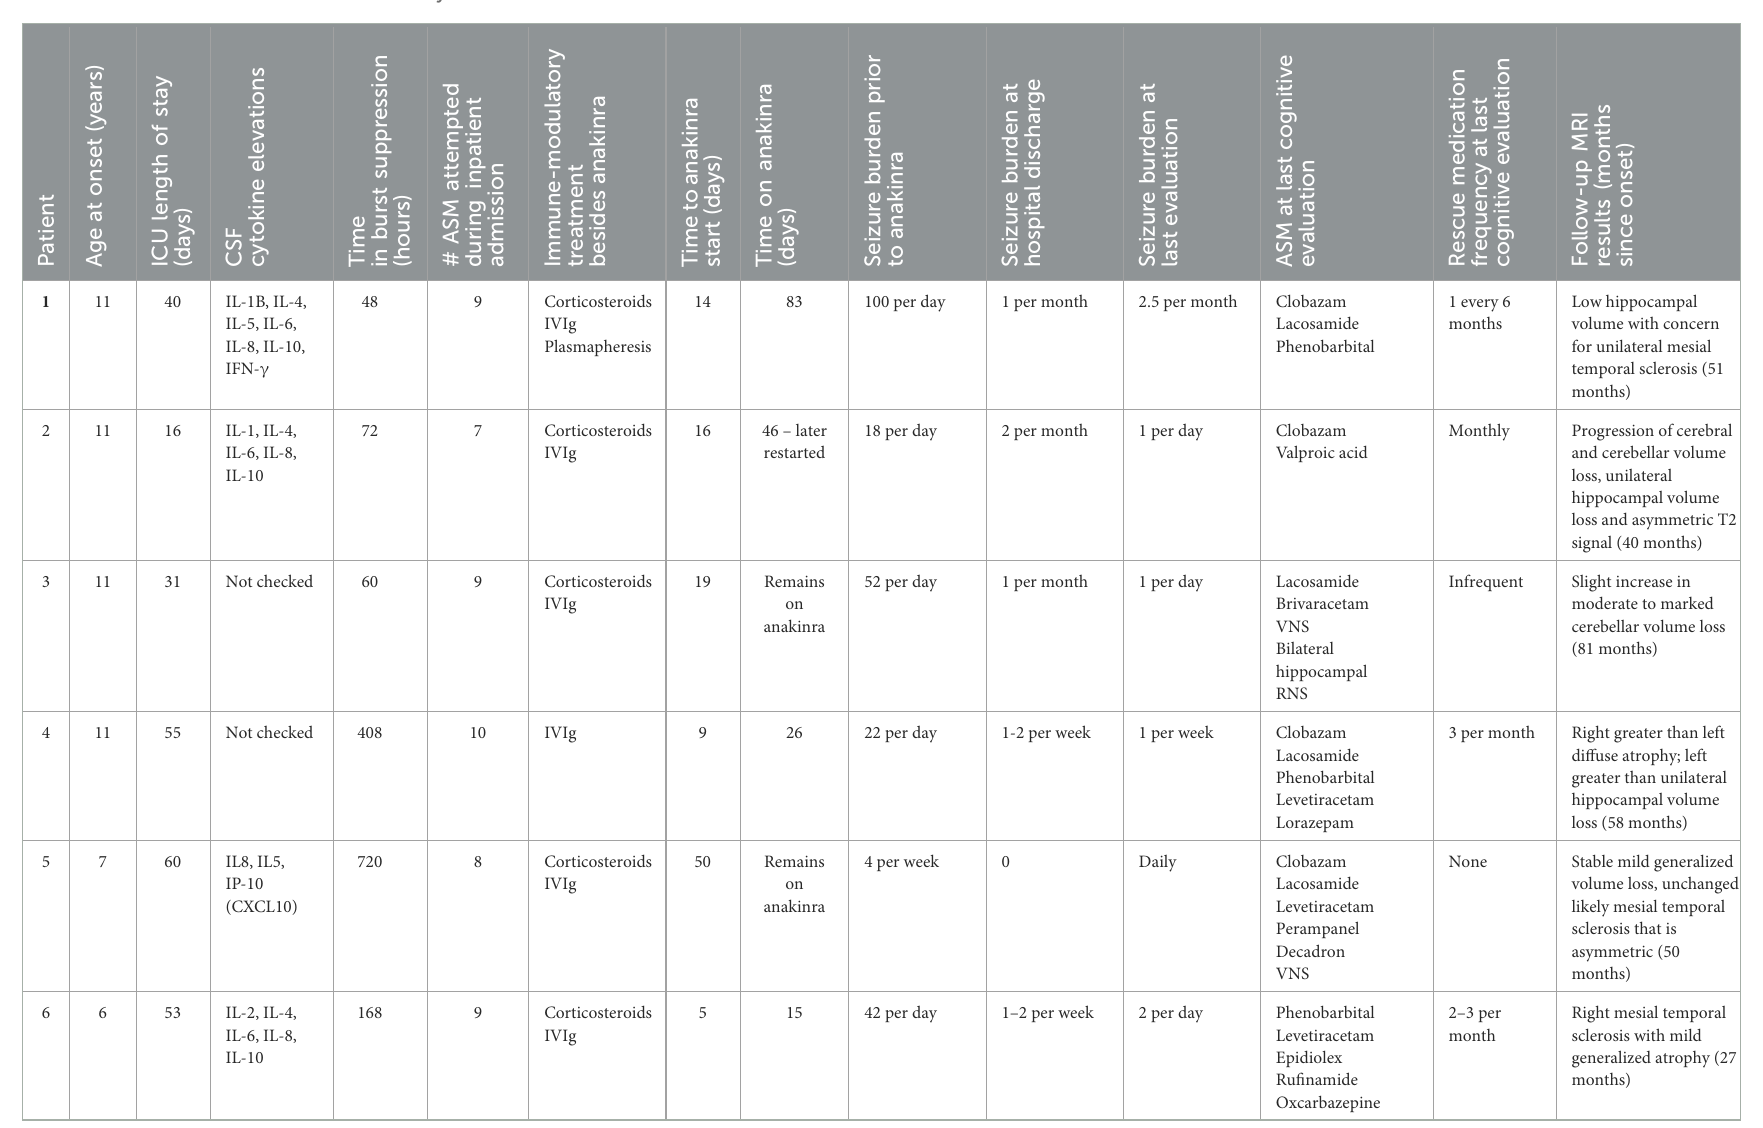
TABLE 1 Patient characteristics and medical